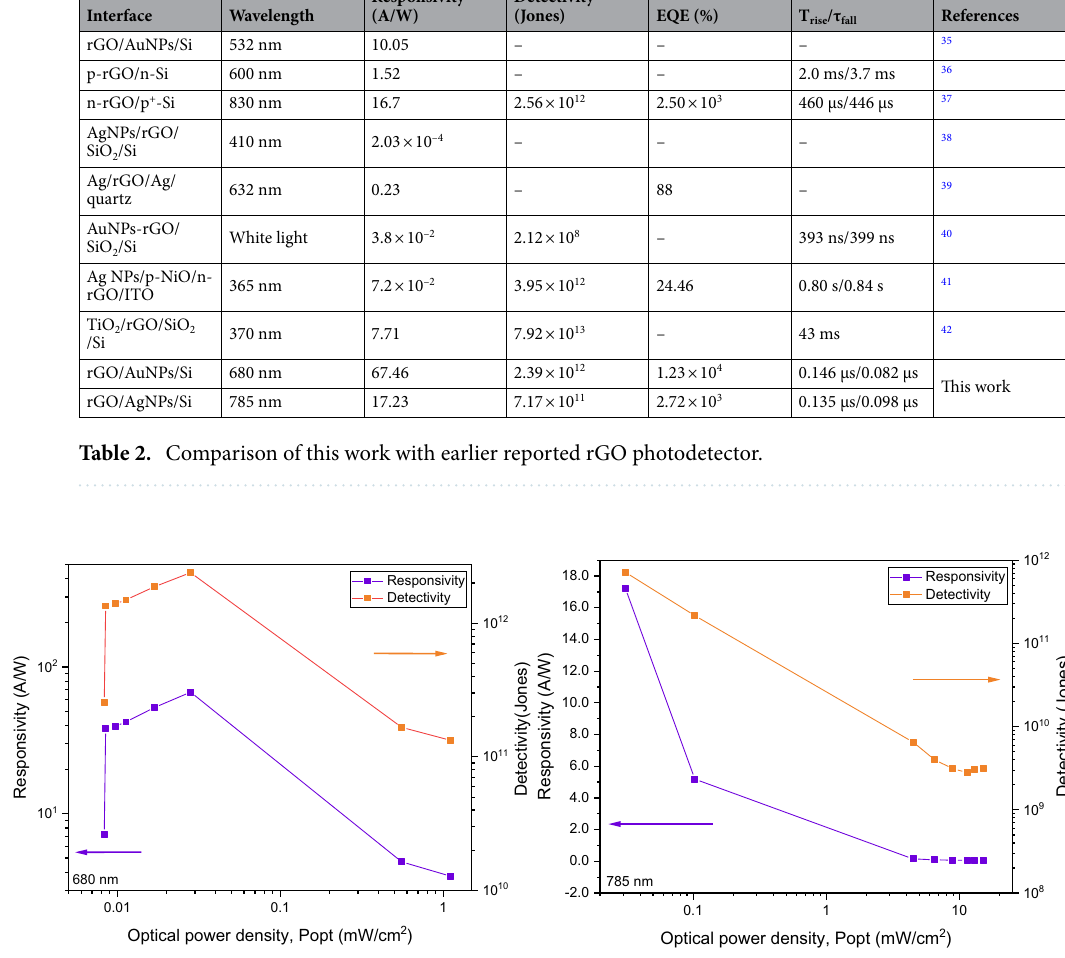
Figure 6. Light intensity-dependent responsivity and detectivity of Au NPs photodetector under illuminations of 680 nm and 785